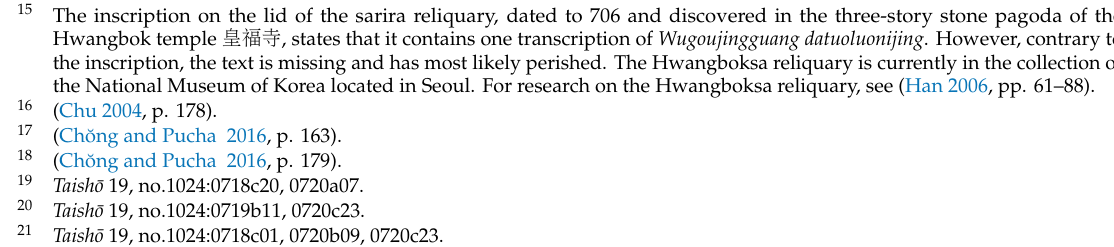
Figure 8. Wugoujingguang datuoluonijing , Unified Silla, eighth-to-ninth centuries, H. 24 cm, Hwa ŏ msa Buddhist Museum [©CBM].